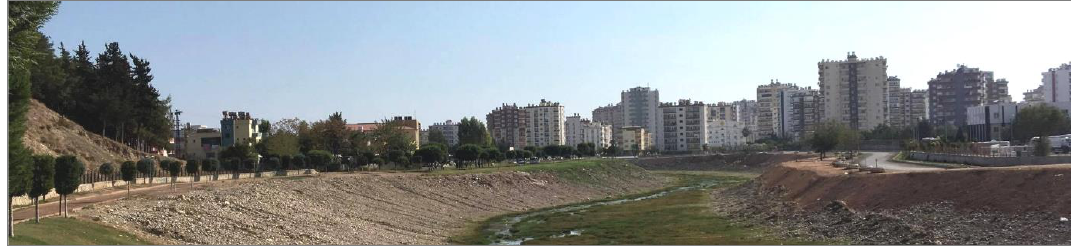
Figure 5 Changing urban silhouette with new constructions across Müftü